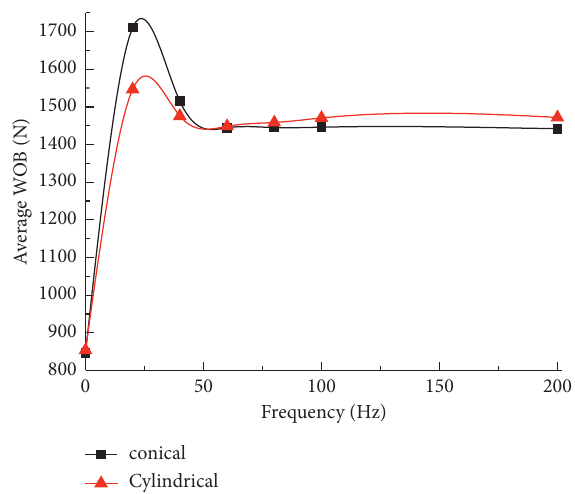
Figure 5: The effect of impact frequency on average WOB.